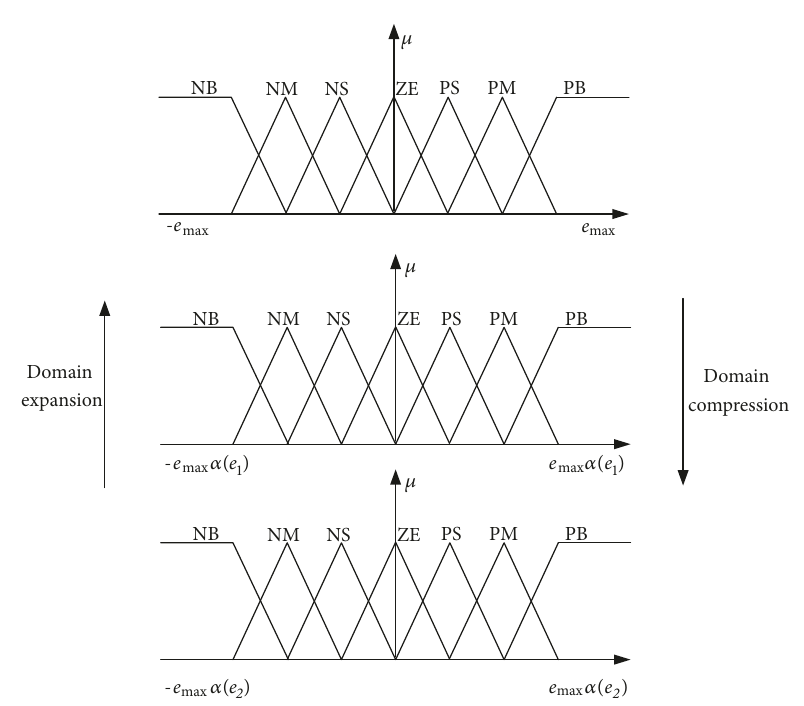
Figure 4: Schematic diagram of the variable